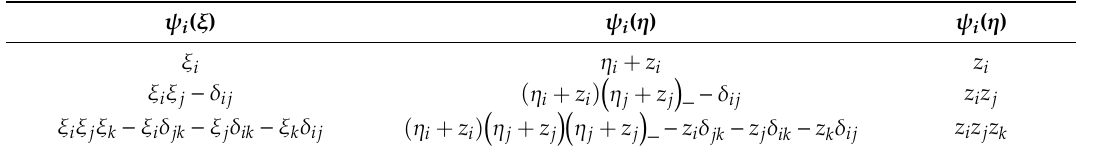
Table 1. ψ i ( η ) used to evaluate the PC coe ffi cients k i ( x )